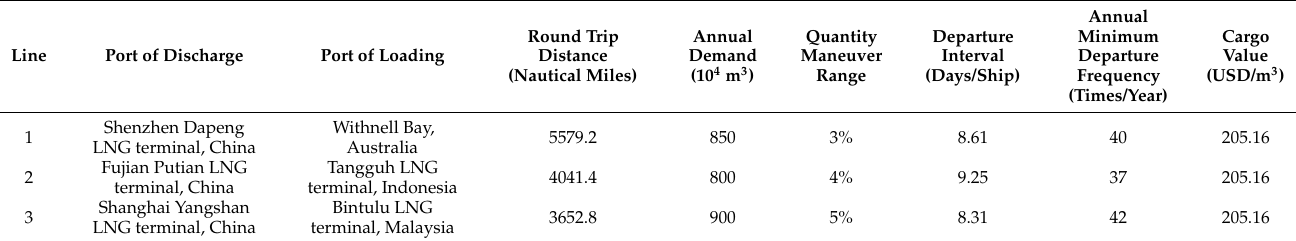
Table 3. Basic information of